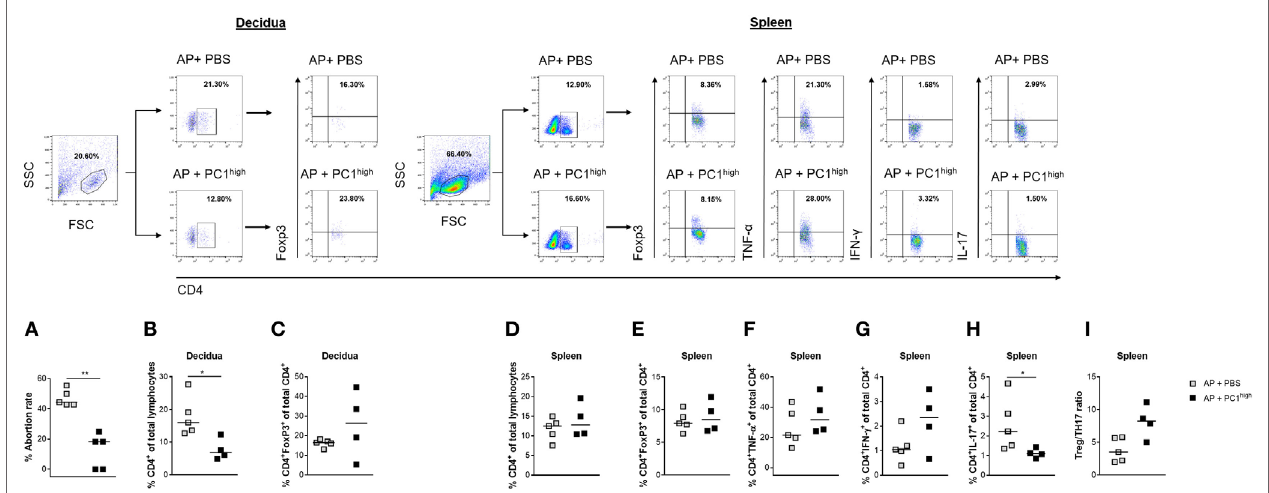
FigUre 5 | Adoptive transfer of PC1 high B1a B cells to AP females protected fetuses from rejection and induced changes in the TH compartment. 1 × 10 5 peritoneal sort-purified PC1 high B1a B cells from normal pregnant females [gestation days (gds) 13–14] were adoptively transferred into AP females ( n = 5) on gd7–9. Control females ( n = 5) received PBS. The recipients were sacrificed on gd12 and the abortion rate (a) was determined. Moreover, CD4 + T cell (B) and CD4 + Foxp3 + regulatory T (Treg) frequencies (c) were assessed in decidual tissue. In spleen, the frequencies of CD4 + T cells (D) , CD4 + Foxp3 + Treg cells (e) , CD4 + TNF- α + (F) , and CD4 + IFN- γ + (g) TH1 cells as well as the frequencies of CD4 + IL-17 + TH17 (h) cells and the Treg/TH17 ratio (i) were determined. Flow cytometry gating strategy and representative dot plots are included in this figure. Graphical data are displayed as medians. Each symbol represents a single animal, and the presented number of mice refers to pooled data of two independent experiments. Statistical analysis was performed using the non-parametric Mann– Whitney- U test (* p ≤ 0.05 and ** p ≤ 0.01). Abbreviation: AP, abortion